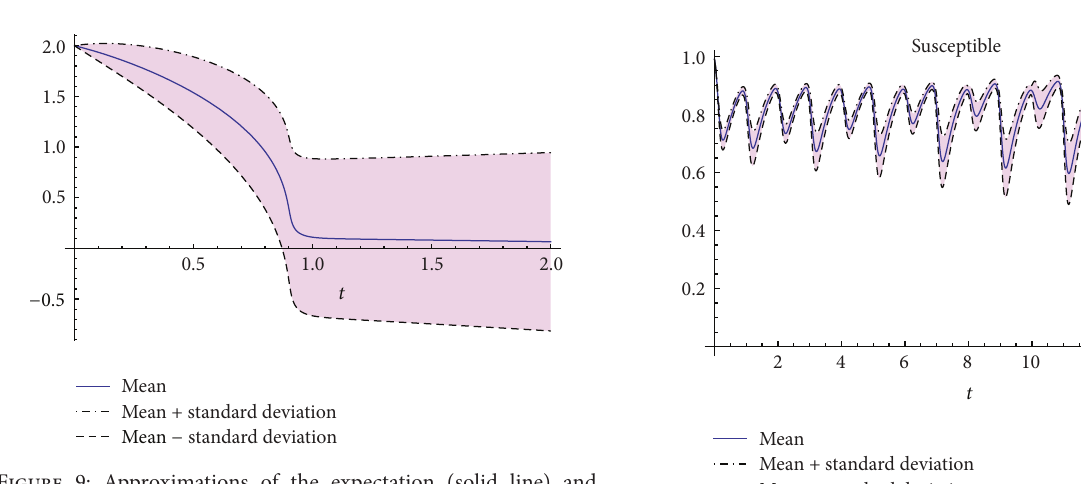
Figure 9: Approximations of the expectation (solid line) and plus/minusstandarddeviation(dashedlines)tothesolutions.p. 𝑦(𝑡) on the interval [0, 2] in Example 7. Figure 10: Approximations of the expectation (solid line) and plus/minus standard deviation (dashed lines) to susceptible ( 𝑆(𝑡) ) on the interval [0,15] in Example 8.